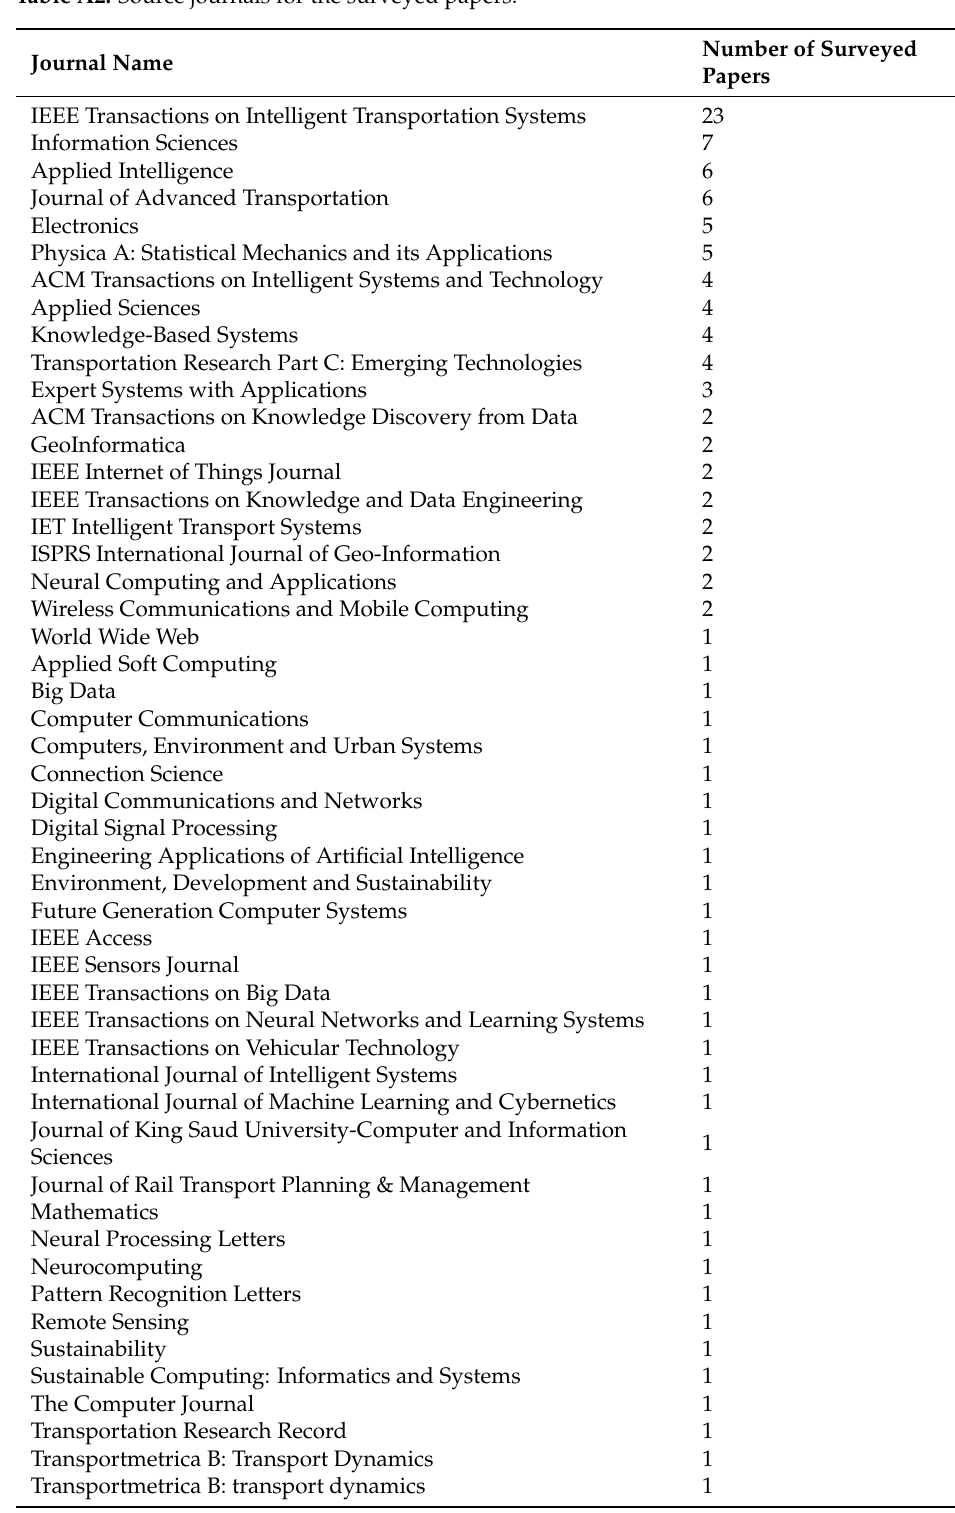
Table A2. Source journals for the surveyed